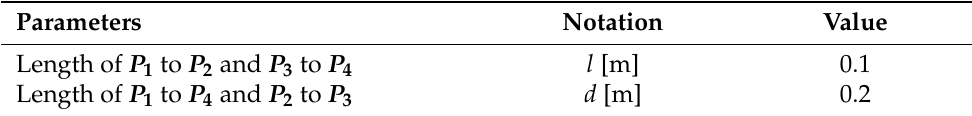
Table 1. Physical